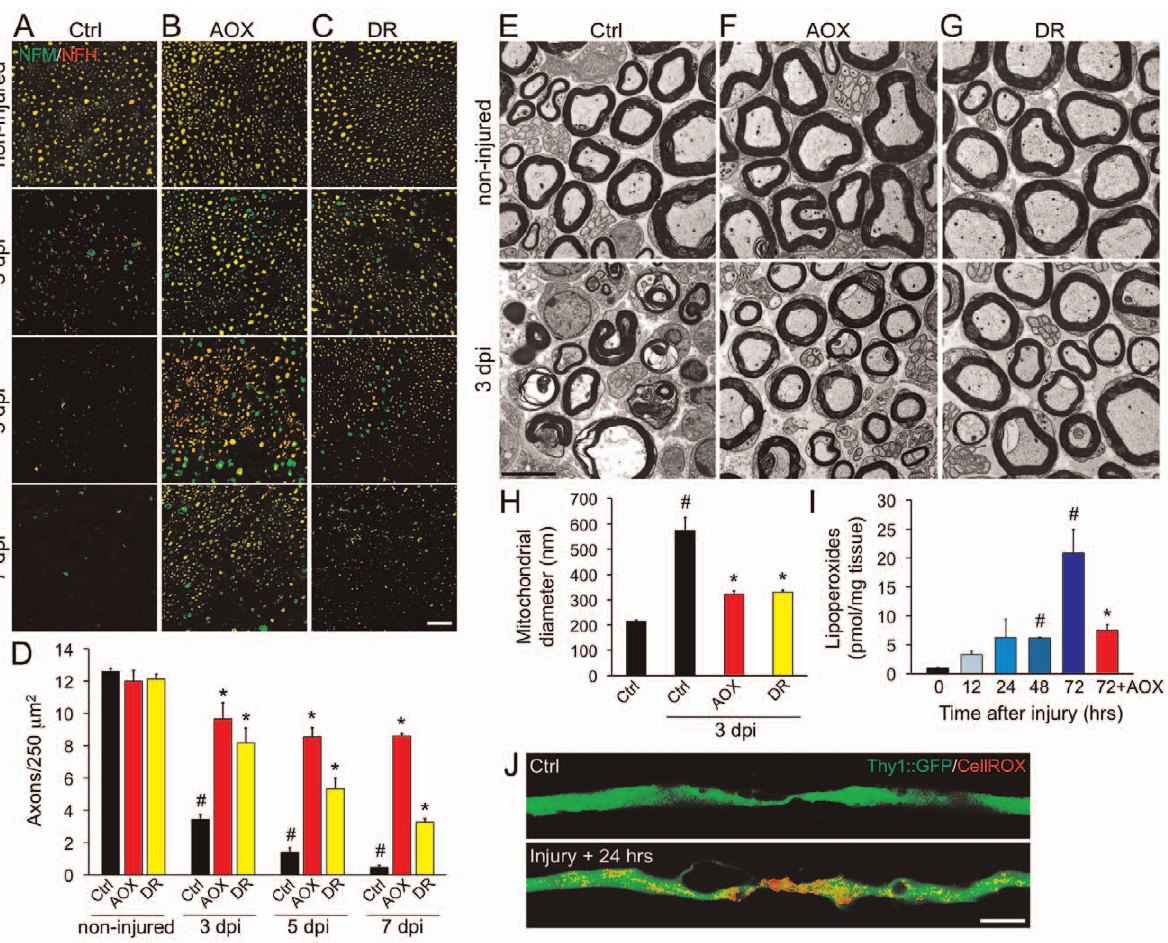
Figure 8. Systemic antioxidant treatment and intermittent fasting delay axonal degeneration in mice. Wild-type mice (C57BL/6J strain) were subjected to systemic treatments of the antioxidant ascorbic acid (AOX) or to dietary restriction (DR) for 10 days. After this, a sciatic nerve injury was performed unilaterally at the sciatic notch level. The degree of axonal degeneration was quantitatively assessed by immunofluorescence using neurofilament antibodies (A–D) and also studied by ultrastructural examination (E–J). (A–C) Transverse sections of sciatic nerves stained for NFM (green) and NFH (red) isoforms in control (upper panels) and 3, 5 and 7 days after injury, distal to the injury region (lower panels). A nerve crush was performed for 3 days experiments and a nerve cut for experiments lasting for 5 and 7 days, to avoid the interference of axonal regeneration in the analysis. The neurofilament signal decrease progressively at 3, 5 and 7 days after nerve injury in non-treated mice (A). Both AOX or DR treatments (B and C, respectively) strongly delays axonal degeneration triggered by nerve injury when observed 3 and 5 days after damage and AOX treatment strongly delays degeneration even at 7 days post injury. Scale bar, 20 m m. (D) Quantification of NFH-positive axons in nerve cross sections as shown in (A–C), expressed as axonal density. In injured nerves, statistically significant protection from axonal degeneration was seen after AOX and DR treatment compared to non-treated mice in all days post-damage (mean values are shown, error bars indicate SEM, N=4 per group; # p , 0.001 by Student’s t test compared with non-injured controls; *p , 0.005 by Student’s t test compared with the respective day post-injury in non-treated mice). Representative electron micrographs (EM) of sciatic nerves from non-treated (E), AOX-treated (F) and DR-treated (G) wild-type mice. Micrographs of non-injured nerves are shown in the upper panels and from nerves 3 days after sciatic nerve crush are shown in the lower panels. In non-injured nerves from all conditions, axons are rounded, myelin sheaths are well preserved and the tissue is well organized. After nerve crush, most axons are degenerated and the myelin sheaths appear collapsed (E, bottom panel). In contrast, crushed nerves from mice systemically treated with AOX or with a restricted dietary intake by intermittent fasting, display preserved axons with conserved myelin sheaths (F and G, lower panels). Scale bar, 5 m m. (H) Diameters of axonal mitochondria were measured in EM transverse sections. The almost three-fold increase in mitochondrial diameter in crushed and non-treated nerves was prevented by both AOX and DR treatment (mean values are shown, error bars indicate SEM, N=75–100 mitochondria/nerve of 3 mice per condition; # p , 0.0001 by Student’s t test compared with non-injured controls; *p , 0.0001 by Student’s t test compared with 3 days after crush in non-treated mice). (I) ROS-dependent lipoperoxidation measured in untreated sciatic nerve explants at 0, 12, 24, 48 and 72 hours post- injury and in nerves treated with the ROS scavenger trolox (1 mM) for 72 hours. Lipoperoxide levels progressively increase after nerve damage and AOX treatment strongly inhibit injury induced lipid peroxidation (mean values are shown, error bars indicate SEM, N=4 per group; # p , 0.05 and *p , 0.01 by Student’s t test compared with time 0; the AOX values are compared statistically with 72 hours non-treated nerves). (J) In situ ROS detection in YFP-expressing axons (green) using the vital dye CellROX (red). Uninjured axons have ROS levels not detectable by this technique, which increases considerable at 24 hours post damage. Scale bar, 5 m m.